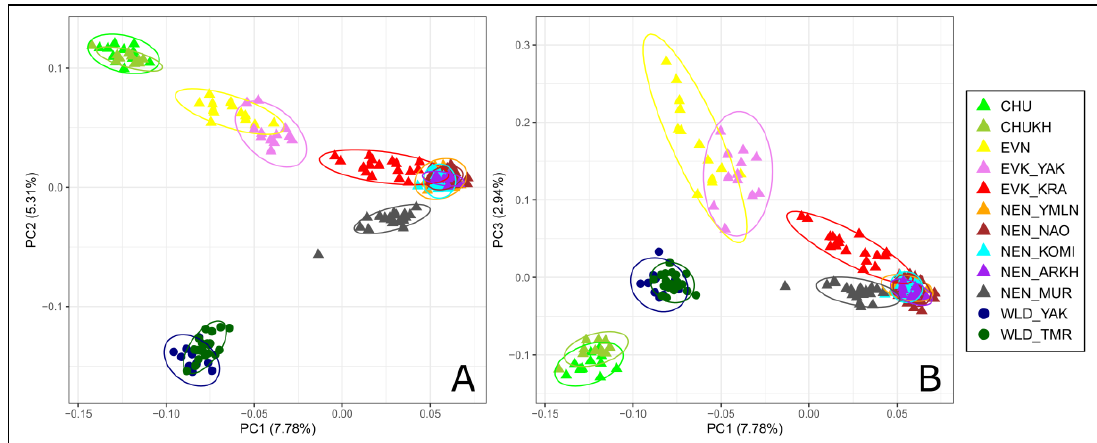
Figure 4. Principal component analysis (PCA) analysis of the Russian reindeer breeds: ( A ) the first two components (PC1 and PC2), which, together, explain 13% of the genetic variability and ( B ) the first and third components (PC1 and PC3), which, together, explain 10.7% of the genetic variability. 1 CHU, Chukotka; CHUKH, Chukotka–Khargin; EVN, Even; EVK_YAK, Evenk of the Yakutia region; EVK_KRA, Evenk of the Krasnoyarsk region; NEN_YMLN, Nenets of the Yamalo-Nenets Autonomous district; NEN_NAO, Nenets of the Nenets Autonomous district; NEN_KOMI, Nenets of the Komi Republic; NEN_ARKH, Nenets of the Arkhangelsk region; NEN_MUR, Nenets of the Murmansk region; WLD_YAK, wild reindeer of Northern Yakutia; WLD_TMR, wild reindeer of Western Taymyr.